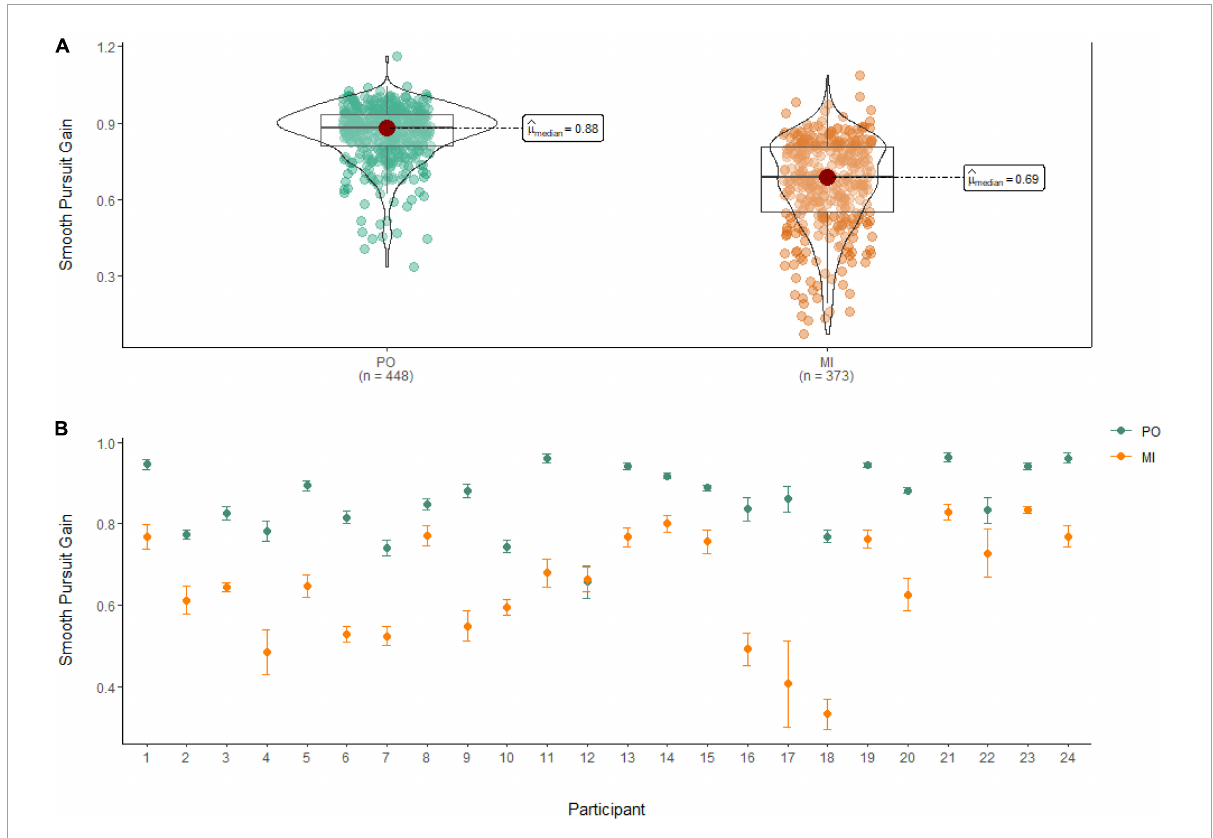
FIGURE5 (A) Smooth pursuit gain differences between PO (left) and MI (right). (B) The average gain of smooth pursuit for PO (blue) and MI (orange) is displayed for each of the 24 participants enrolled in the experiment. Error bars are standard error of the